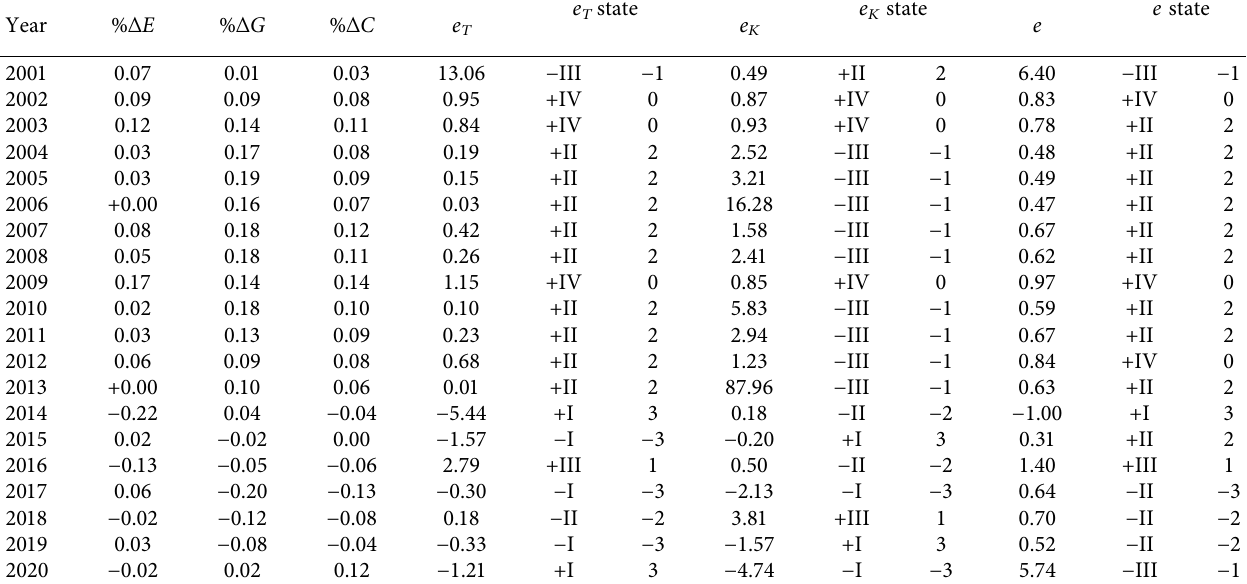
Table 13: Decoupling index and decoupling relationship of mining industry from 2001 to 2020.